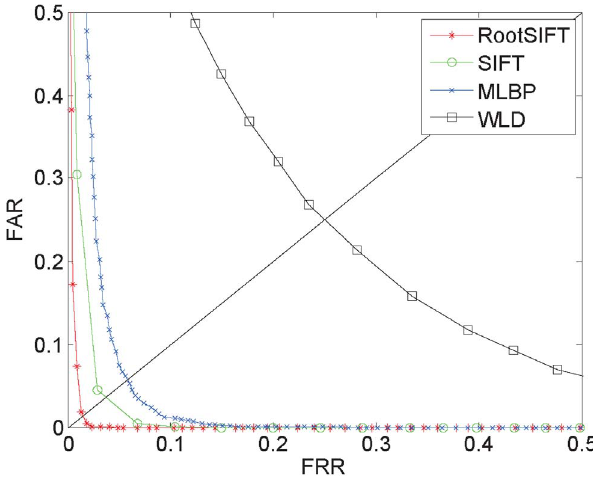
Figure 11. EER curves for different approaches.